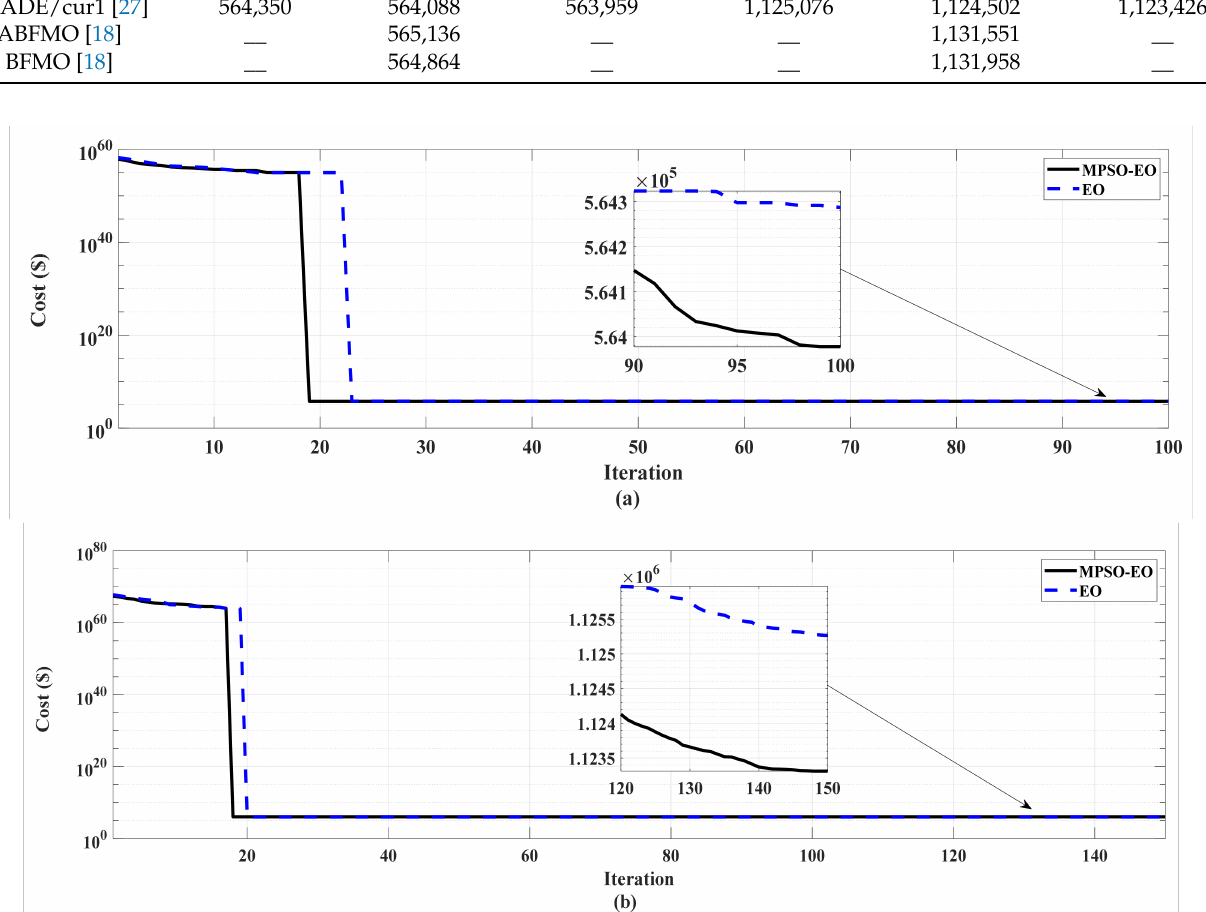
Figure 5. Comparison of convergence characteristics between MPSO-EO and EO (test system 1): ( a ) 10-unit system and ( b ) 20-unit